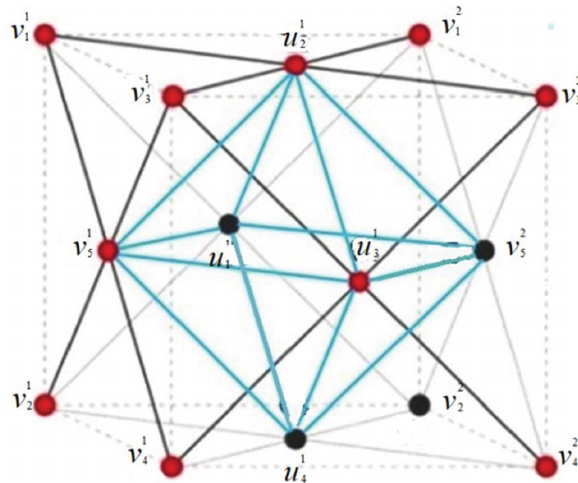
Figure 1: FFC ( 1 ): A unit cell of face-centered cubic ( FCC )